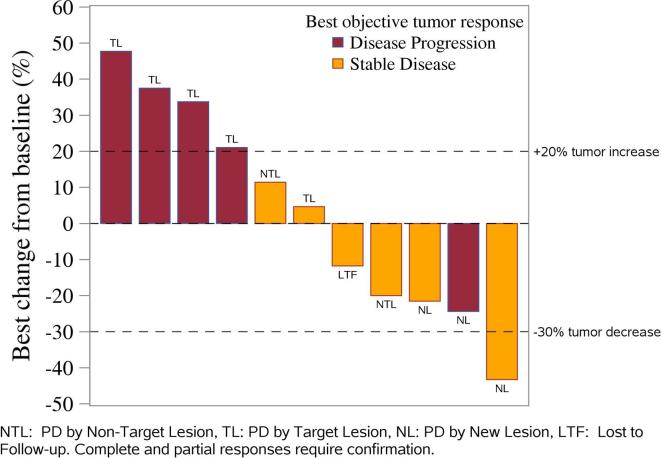
Waterfall plot showing distribution of the best percentage change in target lesion size from baseline for an individual patient. The lines (–30 and +20%) indicate the region with change from baseline that typically represent SD based on RECIST guidelines. Please note that patient with a >30% decrease in tumor volume had a new lesion at the time of the unconfirmed PR. Thus, the patient progressed and a partial response was not confirmed.